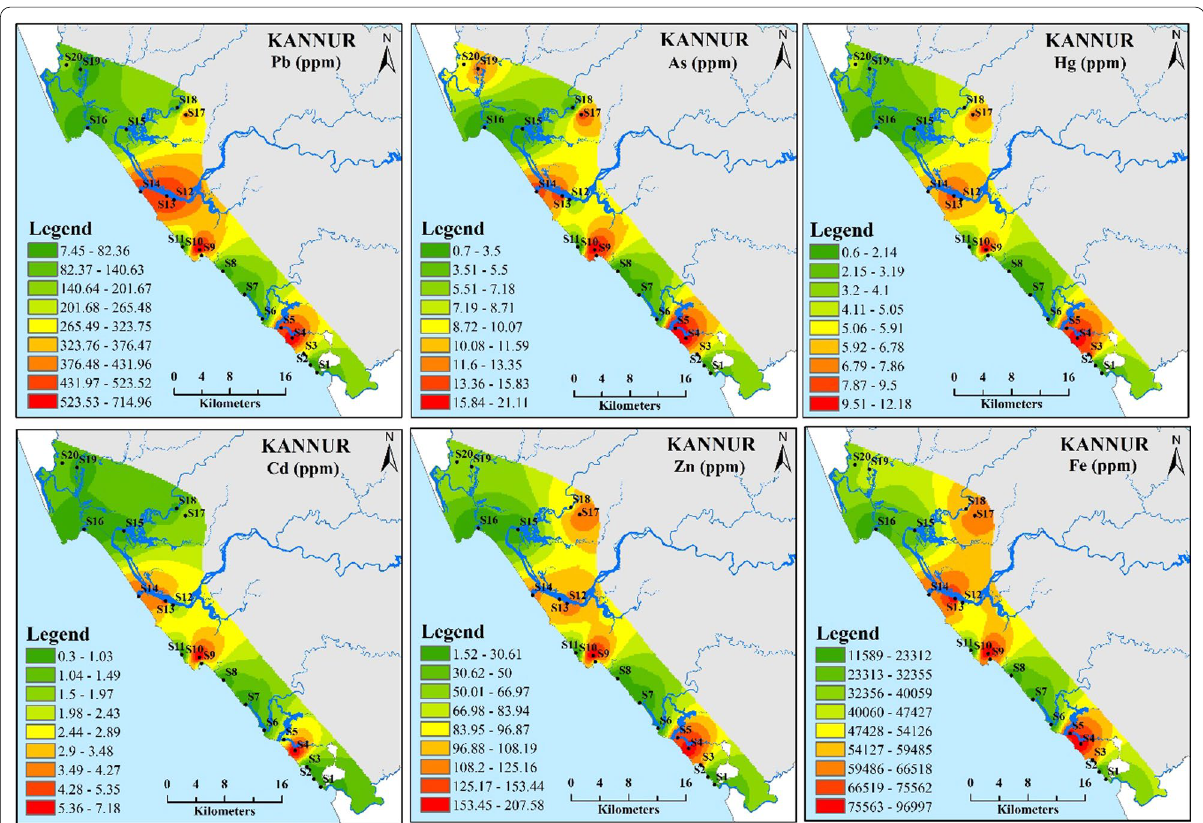
Fig. 3 Spatial distribution of heavy metals in soil samples of Kannur